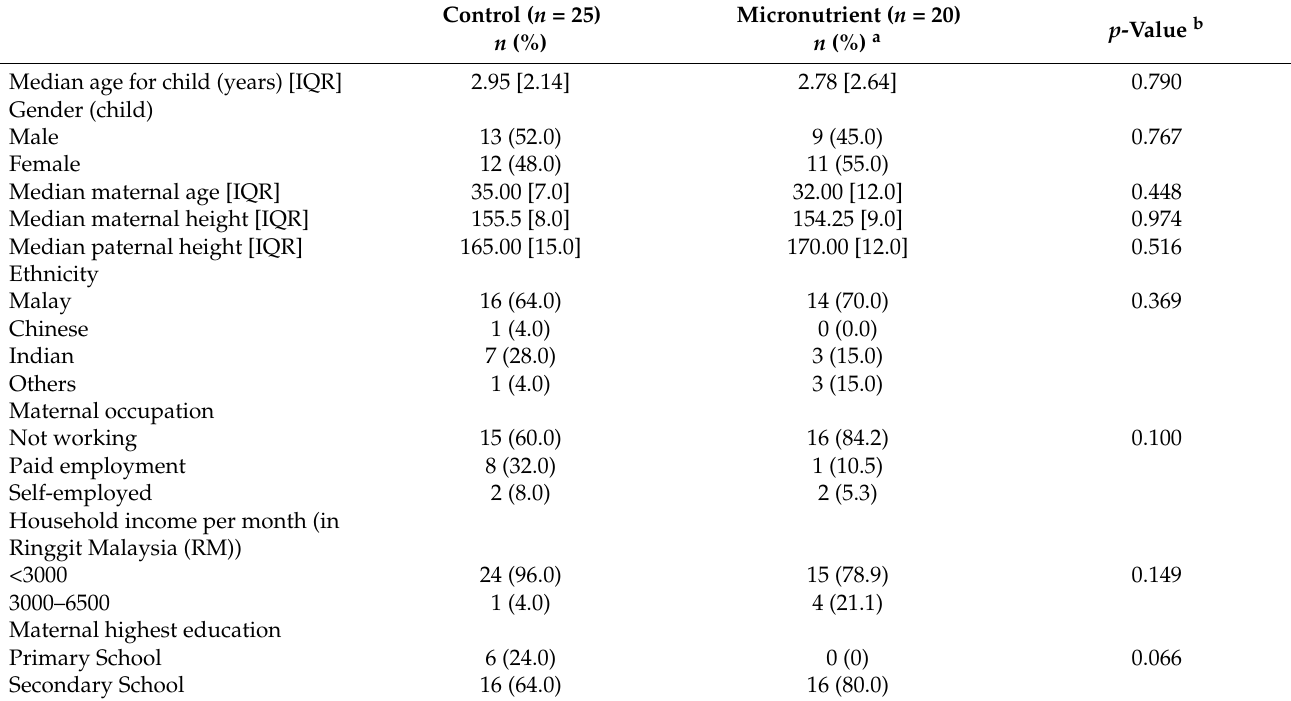
Table 2. Comparisons of baseline parameters between control and micronutrient groups ( n = 45).